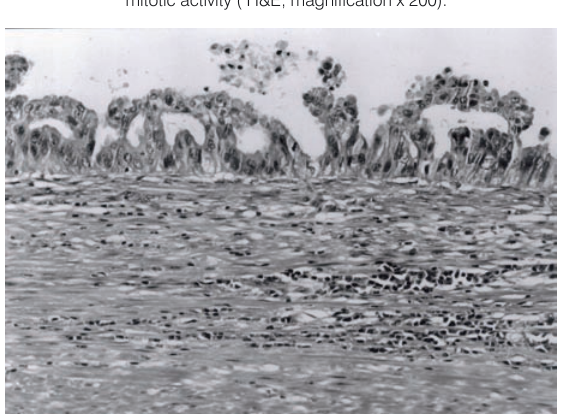
Figure 3. High-grade dysplasia lining duplication cyst. Note variation in nuclear shape and size with stratification, bridging and mitotic activity ( H&E, magnification x 200).